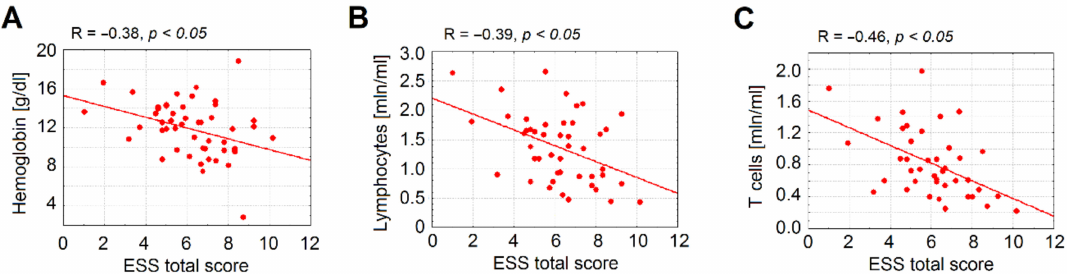
Figure 3. Negative correlation of the epistaxis severity and immune parameters. In patients with HHT and higher Epistaxis Severity Score (ESS), lower hemoglobin ( A ), lymphocyte ( B ), and T cell ( C ) levels were documented. Number of HHT patients = 40, HHT = hereditary hemorrhagic telangiectasia, ESS = Epistaxis Severity Score (on a scale from 1 = mild epistaxis to 10 = severe epistaxis). In multivariate regression analysis, the hemoglobin level was associated with lymphocytopenia (hemoglobin level: odds ratio (OR) = 0.625, 95% confidence interval (CI): 0.417–0.937, p = 0.023;